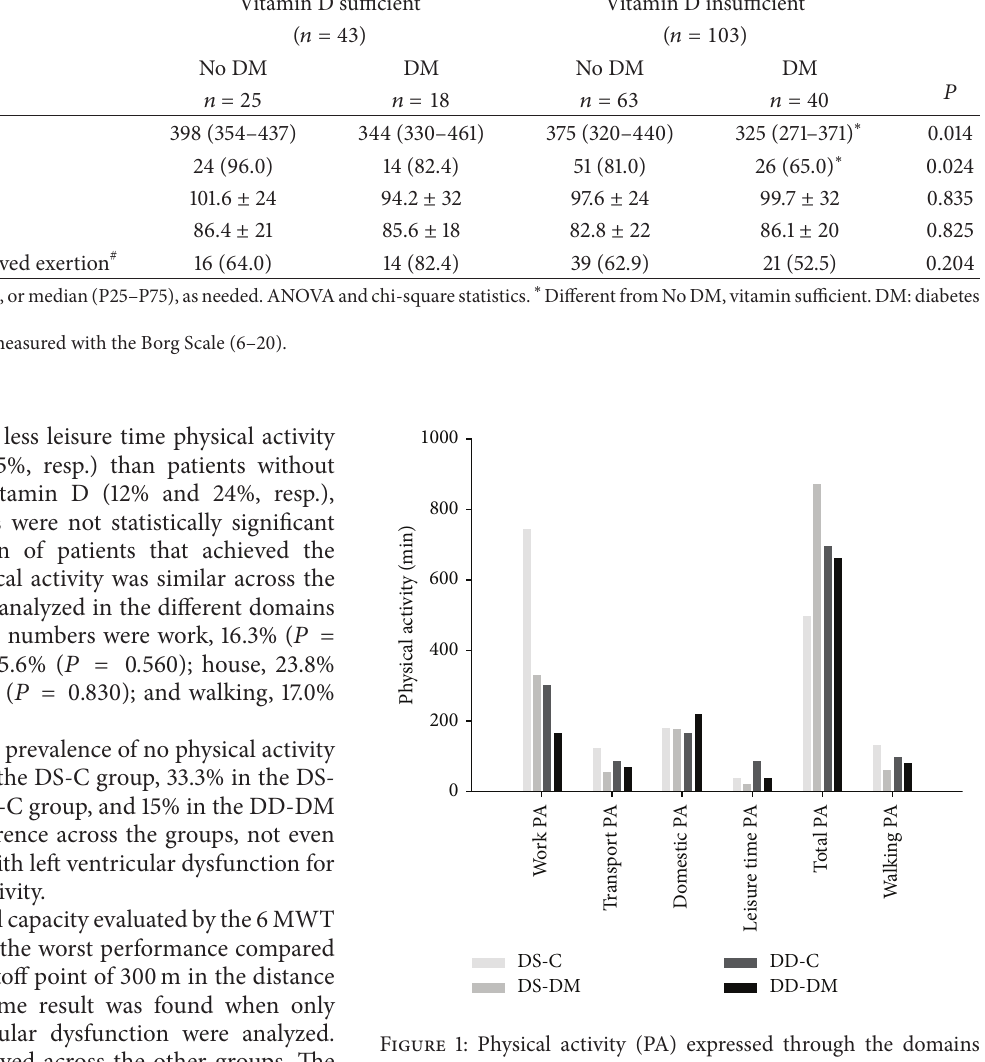
Figure 1: Physical activity (PA) expressed through the domains obtained from the IPAQ for the groups studied (no vitamin defi- ciency and no diabetes, DS-C; no vitamin deficiency and diabetes, DS-DM; vitamin deficiency and no diabetes, DD-C; and vitamin deficiency and diabetes,